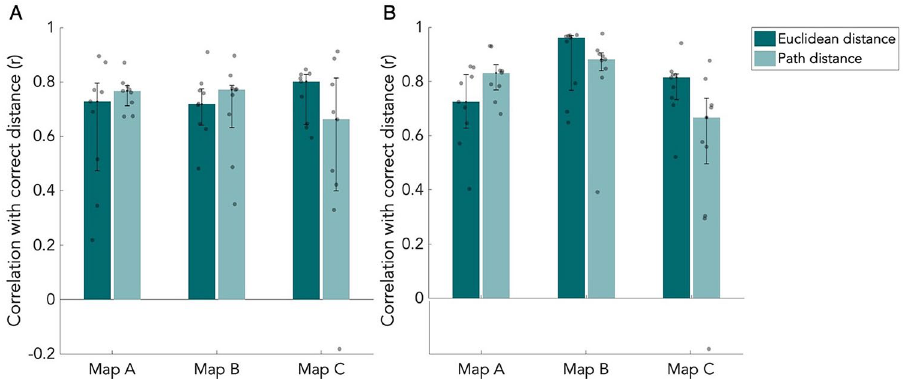
Figure 3. Correlations of the distance estimation task. Median correlation coefficient r of estimated distances with correct distances from the distance estimation task. Results are shown for both Euclidean and path distance for all three maps. Error bars indicate the 25th and 75th percentiles. Grey dots are individual data points. ( A ) Results of the haptic group (n = 9). ( B ) Results of the visuo-haptic group (n = 9).